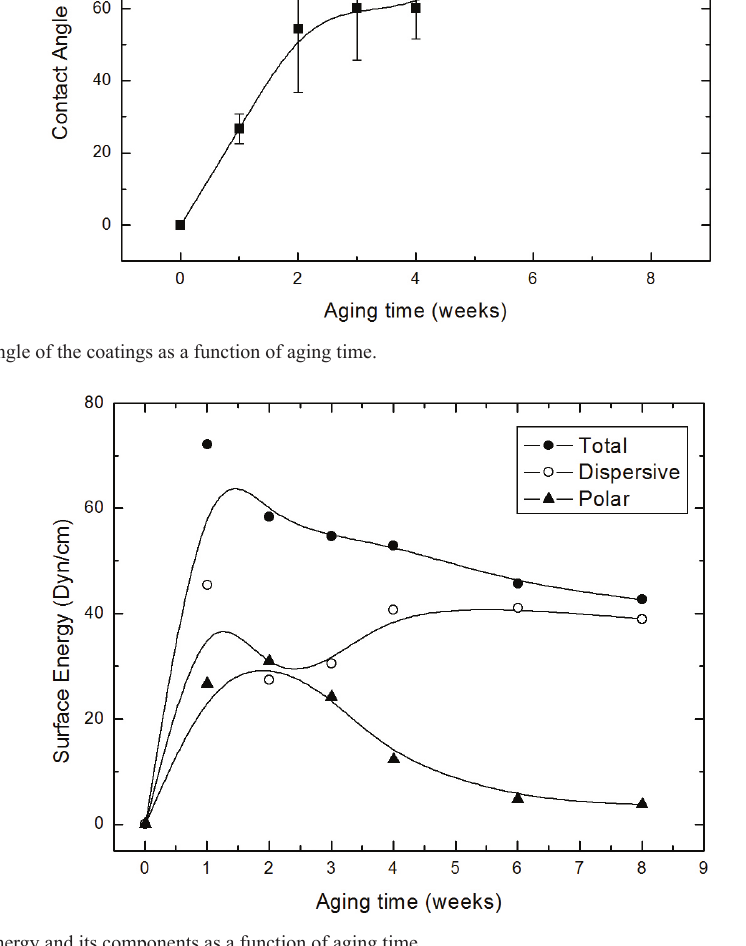
Figure 6. Surface energy and its components as a function of aging time.